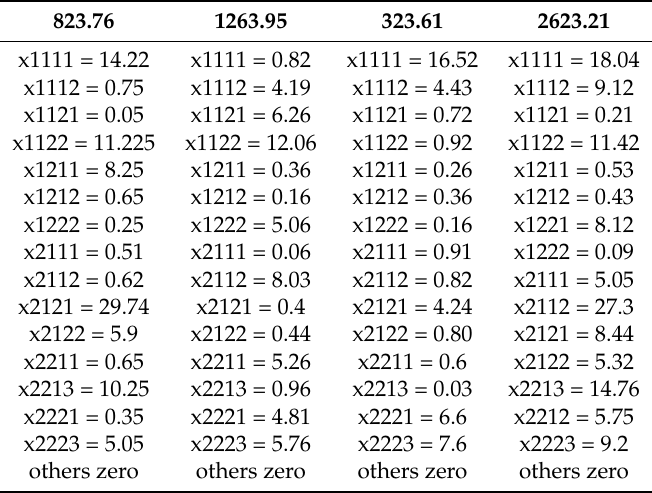
Table 9. Optimum results of the STP Model ignoring route.